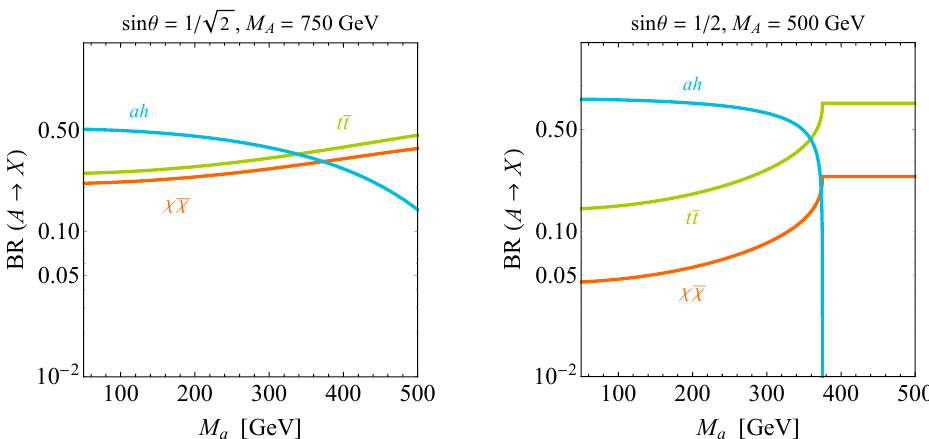
Figure 5 . Branching ratios of the heavier pseudoscalar A as a function of M a for two di(cid:11)erent choices of M A and sin (cid:18) as indicated in the headline of the plots. The other parameter choices are tan (cid:12) = 1, M H = M H (cid:6) = 750 GeV, (cid:21) 3 = (cid:21) P 1 = (cid:21) P 2 = 0, y (cid:31) = 1 and m (cid:31) = 1